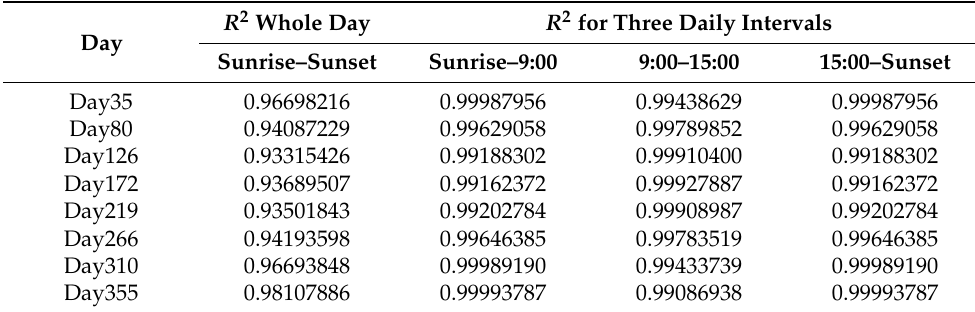
Table 1. Reliability coefficient values for the sunrise–sunset